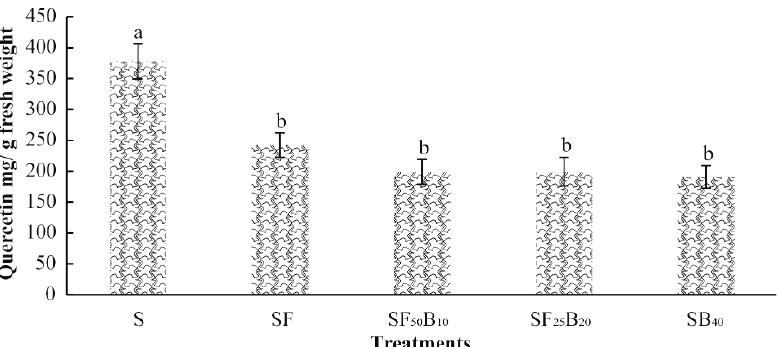
Figure 4. Peroxidase activity (POX) in basil ( Ocimum basilicum L.) cultivated in a soil with treatments, S, soil without fertilizer (control); SF, soil + fertilizer (N:P:K 100:40:40); SF 50 B 10 , soil + fertilizer (N:P:K, 50:20:20) + biosolid (10 t ha −1 ); SF 25 B 20 , soil + fertilizer (N:P:K, 25:10:10) + biosolid (20 t ha −1 ) and SB 40 , soil + biosolid (40 t ha −1 ). Means ± standard error, bars with different letters are significantly different according to LSD test ( p < 0.05).